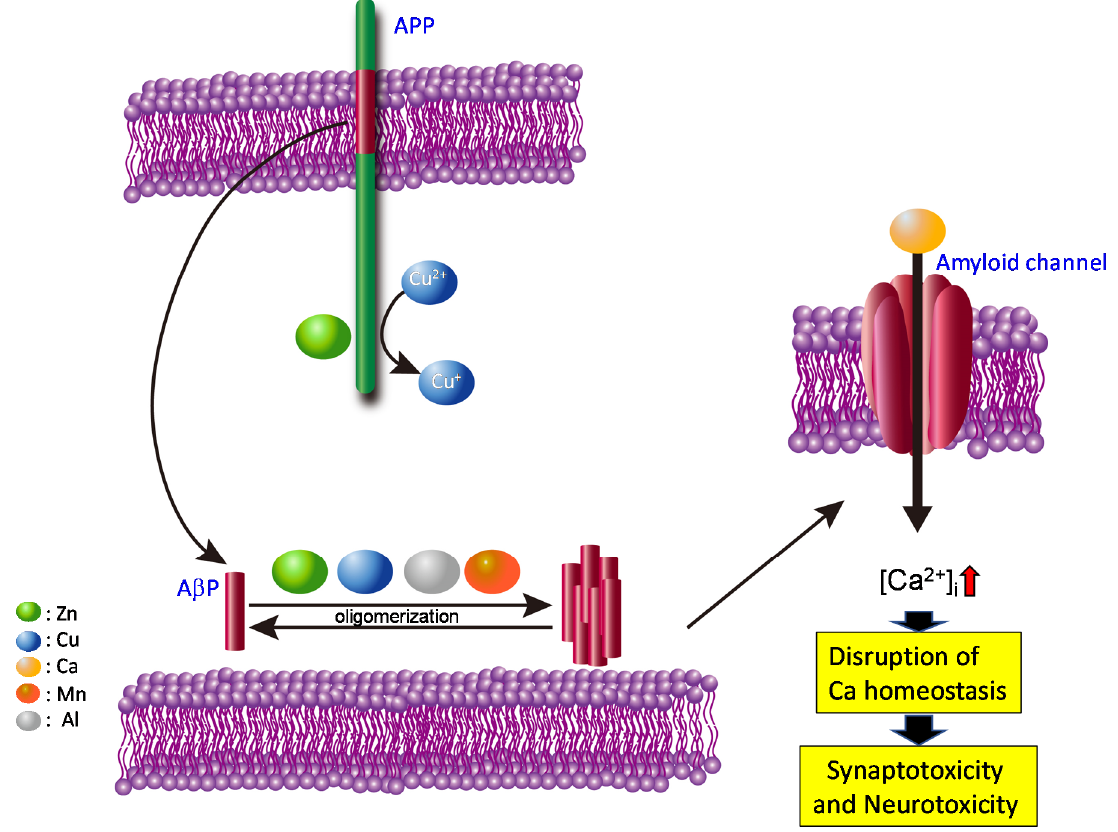
Figure 3. Hypothesis: gain of toxic functions of amyloid oligomers at the synapse.